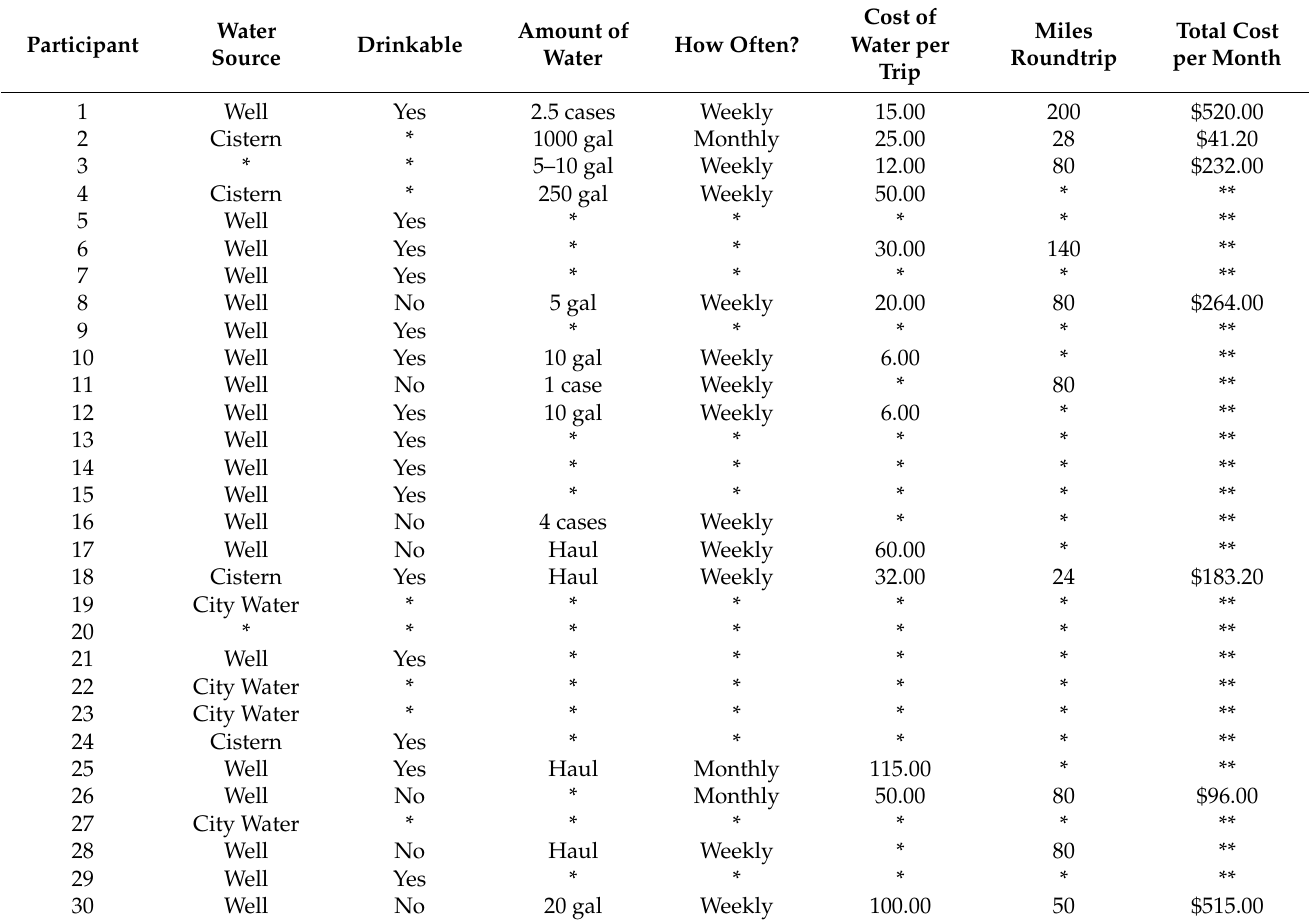
Table 1 came from questions asking participants how they obtained water for household use. Due to the open-ended nature of the interview, not everyone provided data related to hauling water. For example, people who reported that their water source was city water did not haul water and some people with wells considered their water safe to drink. Table 1. Household water sources and associated water hauling costs per